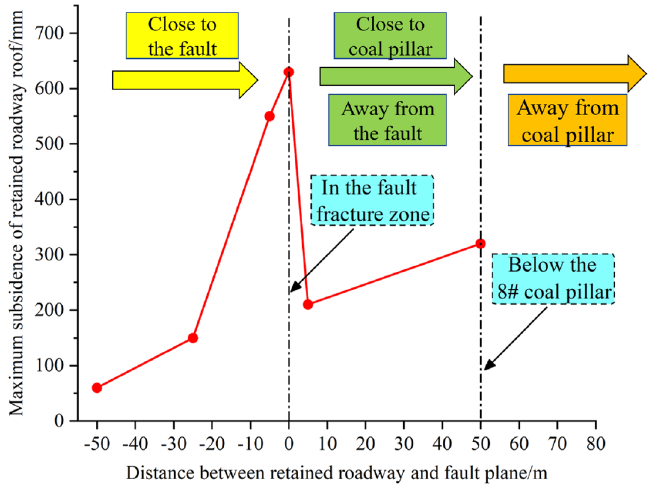
Figure 15. Summary of the maximum subsidence of the formed roadway roof under different mining